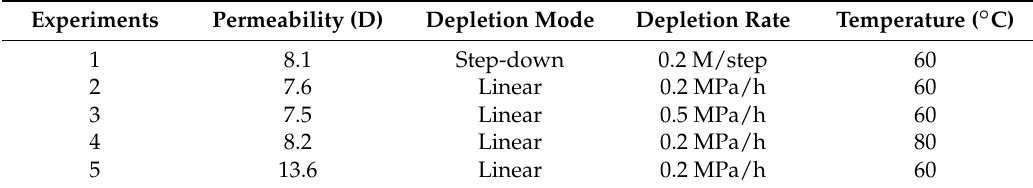
Table 2. Conditions for five foamy oil